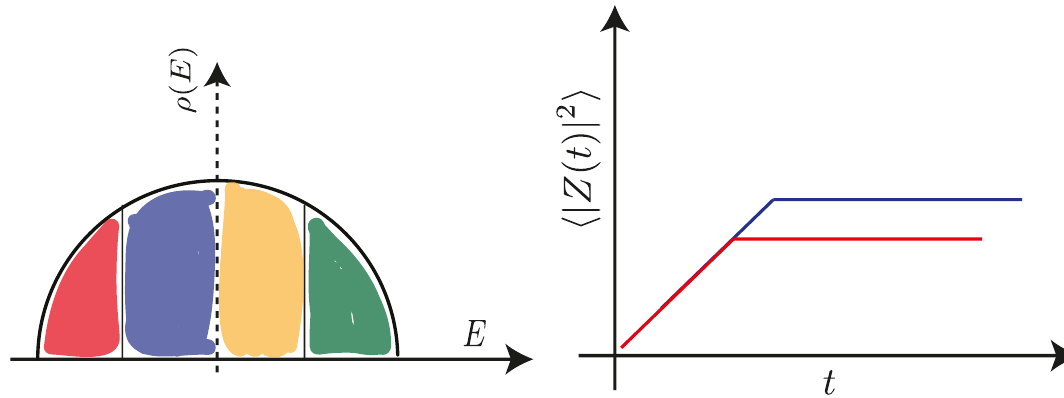
Figure 2 . [Left] Equal width slices of the energy spectrum marked with di(cid:11)erent colors. [Right] Ramp and plateau coming from two slices marked with the corresponding